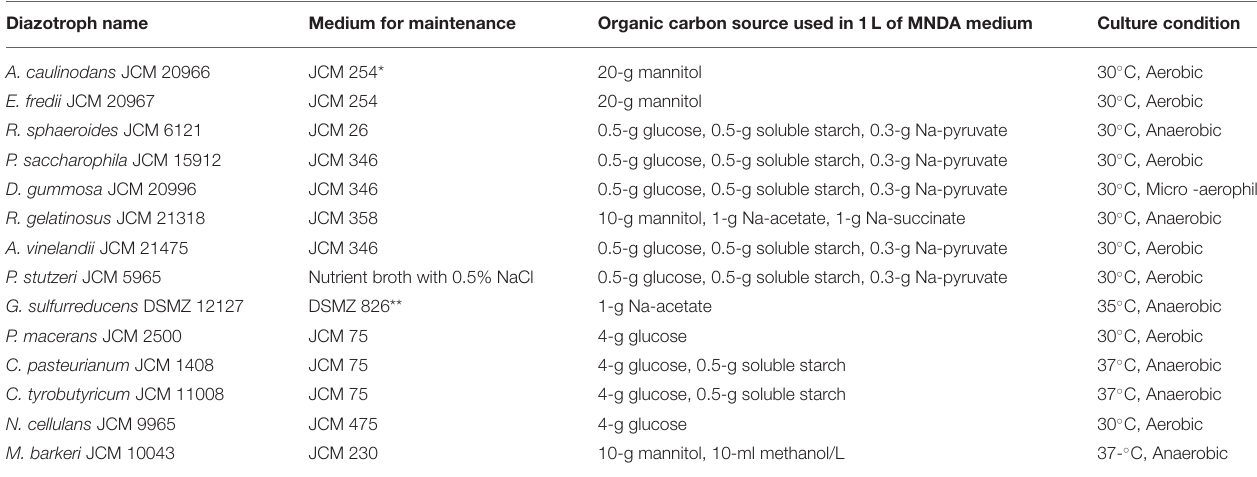
TABLE 1 | List of the studied diazotrophs with their culture